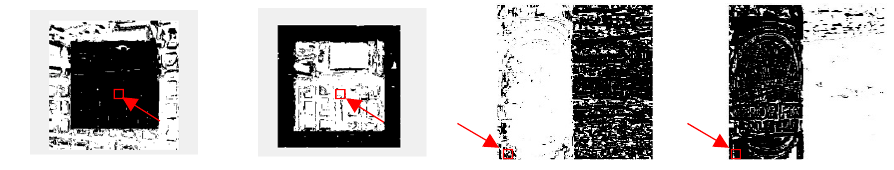
Figure 2. Figure 2.